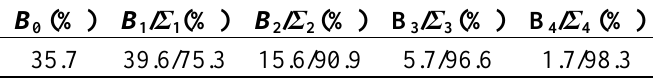
Table 4. Percentage of extracted outlines in buffer zones .